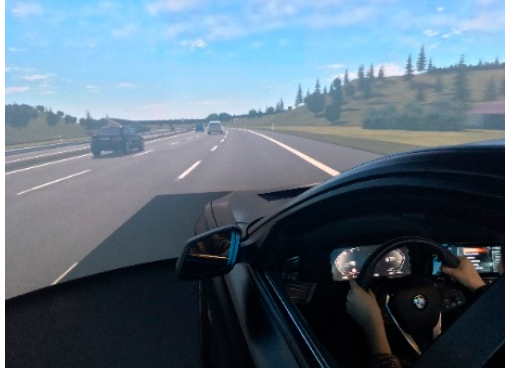
Figure 1. Static driving simulator mockup used in the present study.